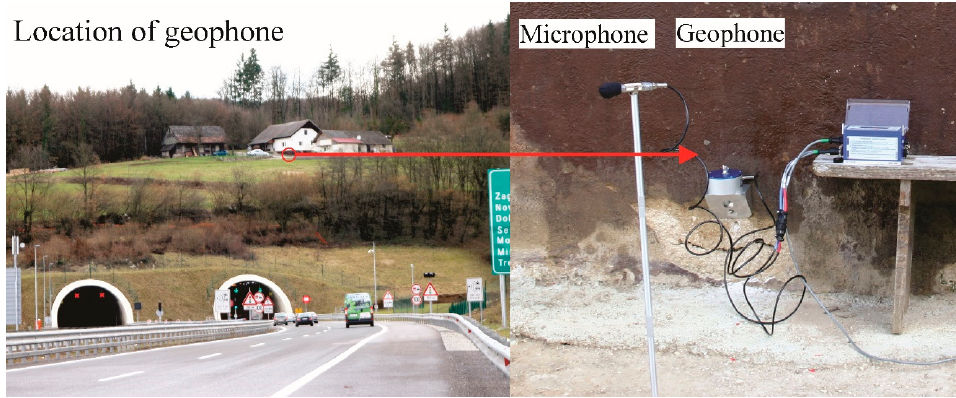
Figure 3. Facility where the monitoring was performed.